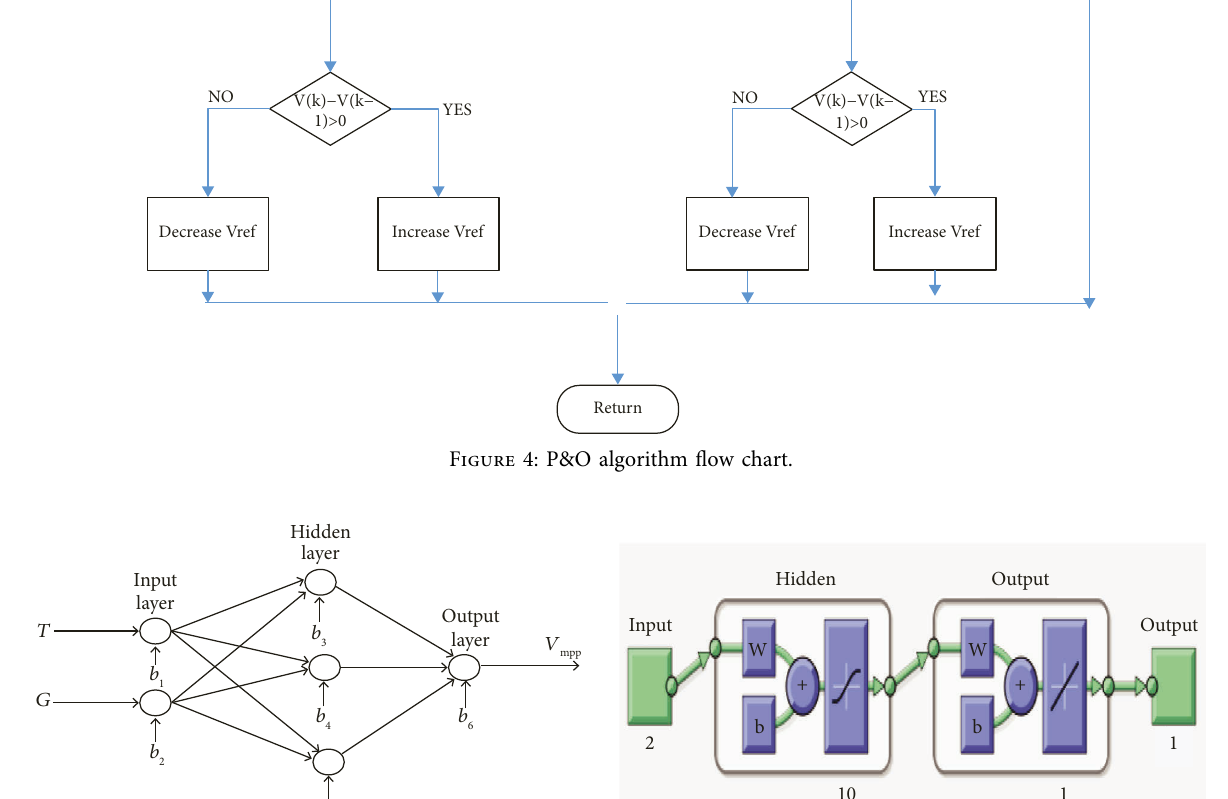
Figure 5: Structure and graphical diagram of ANN.